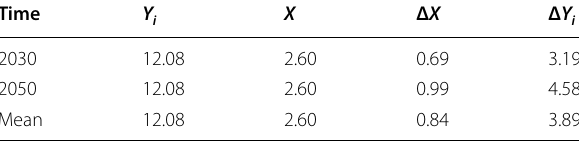
Table 6 Estimation of environmental change index (Δ Y and its components for legal greenbelt plan based on